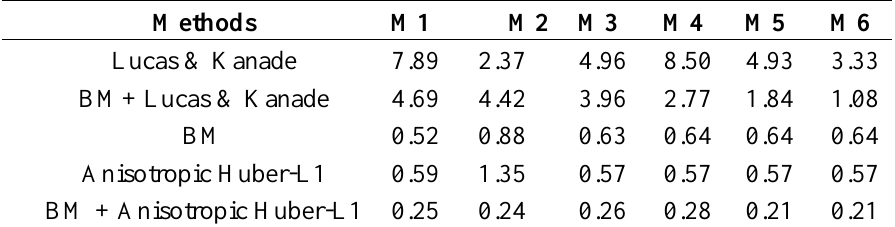
Table A2. Radial error results after being evaluated with different methods.